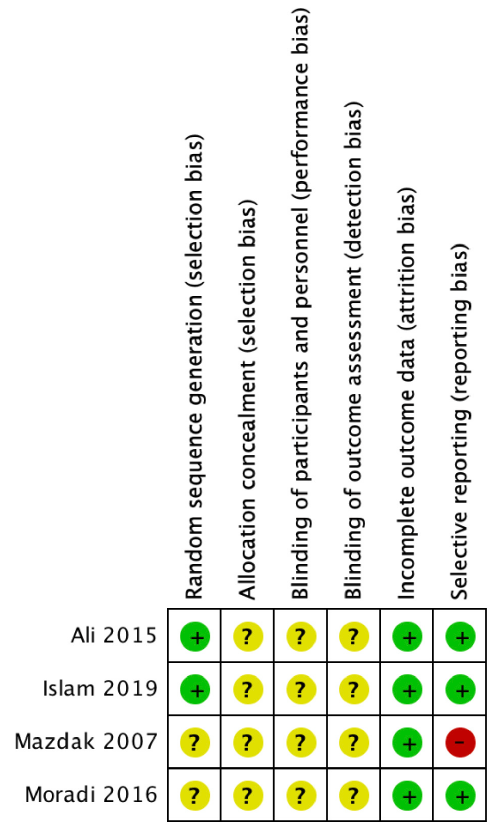
Figure 2. Risk of Bias Summary.